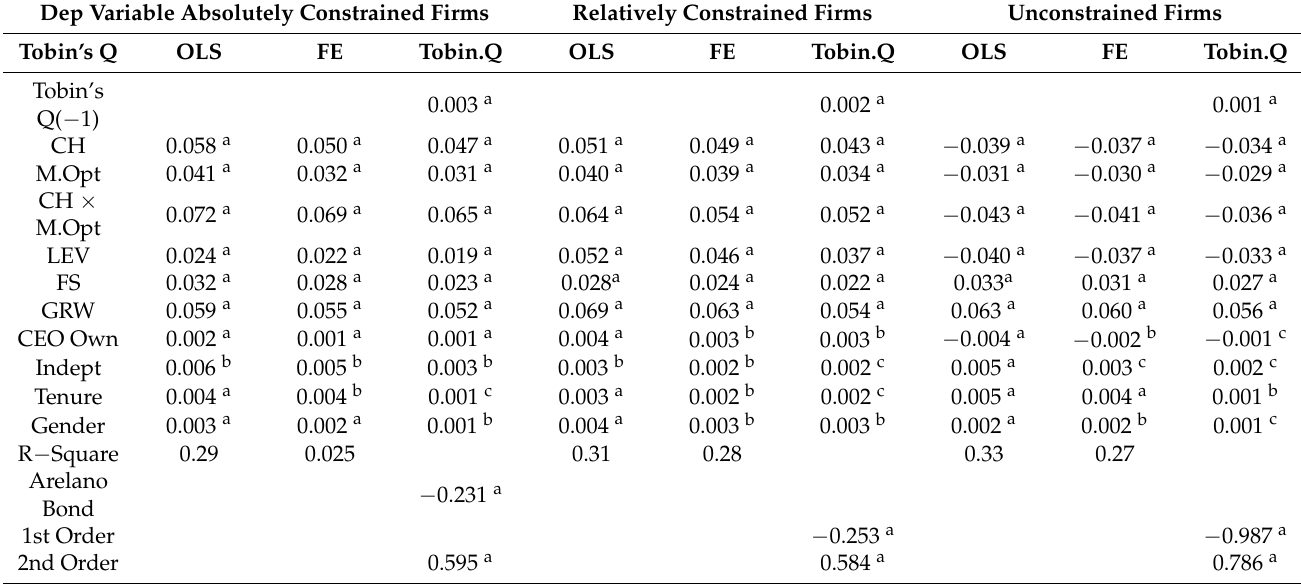
Table 9. Managerial optimism, cash holding, and firm